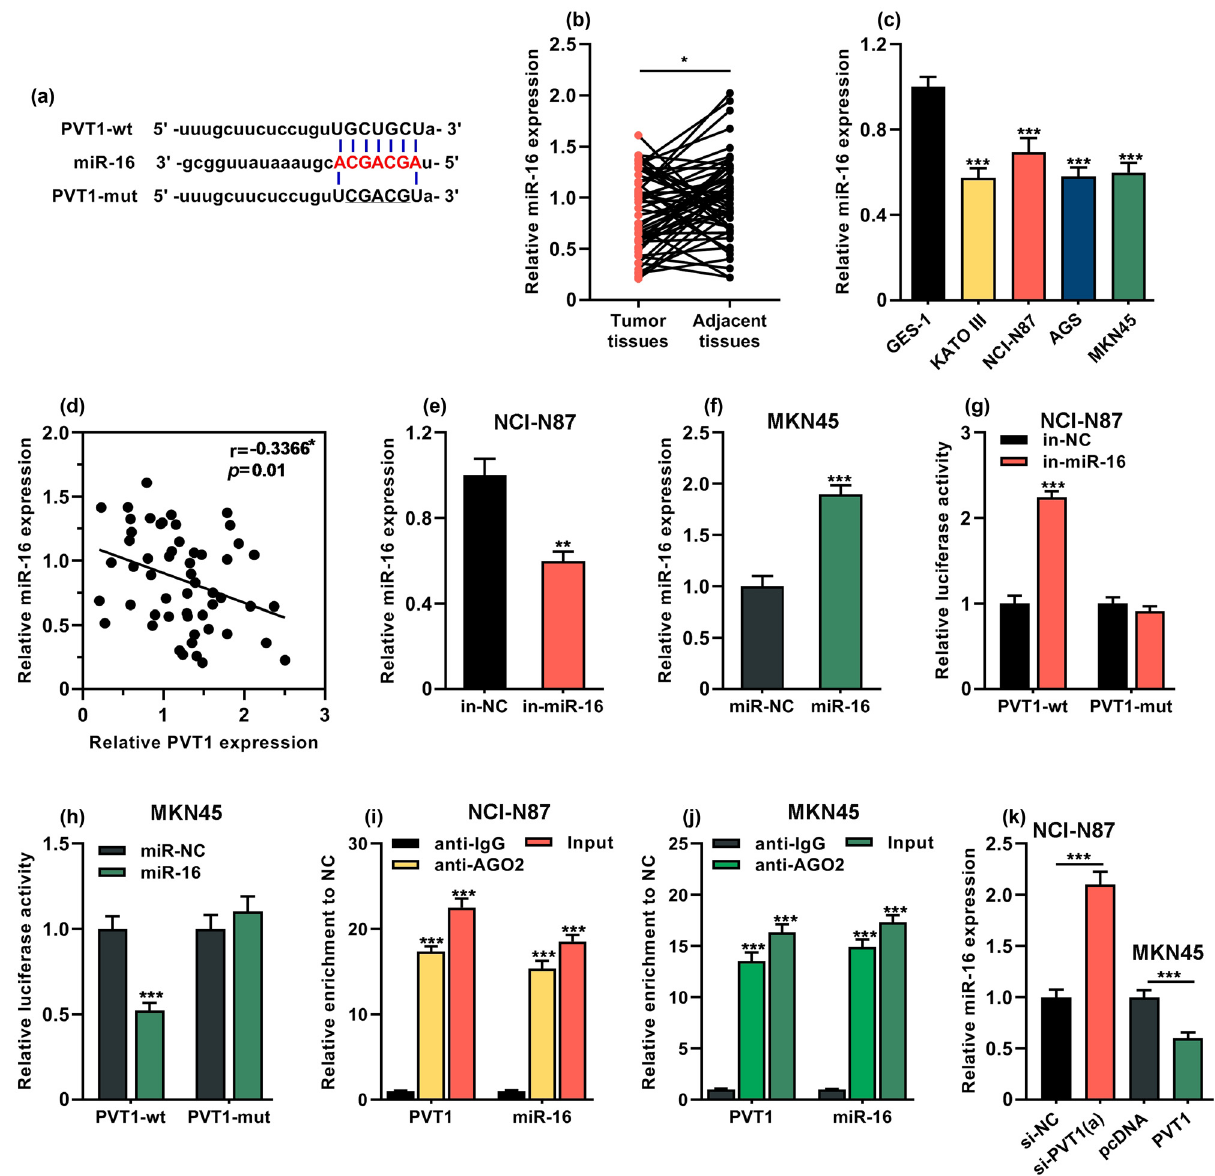
Figure 3: MiR - 16 was directly regulated by PVT1 in GC cells. ( a ) The binding sites of miR - 16 on PVT1. ( b ) qRT - PCR was performed to detect miR - 16 expression in GC tissues ( n = 54 ) and adjacent normal tissues ( n = 54 ) . ( c ) qRT - PCR was performed to detect miR - 16 expression in GES - 1 cells and four GC cell lines ( AGS, NCI - N87, KATO III and MKN45 ) . ( d ) Pearson ’ s correlation analysis was applied to assess